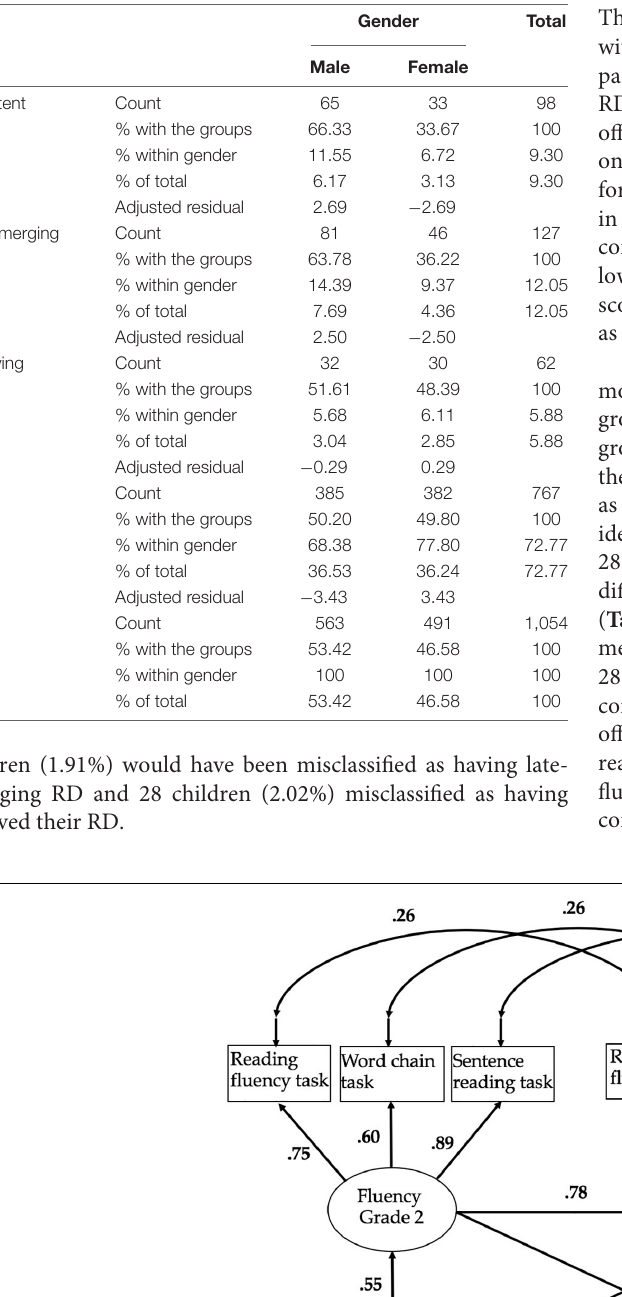
Frontiers in Psychology |